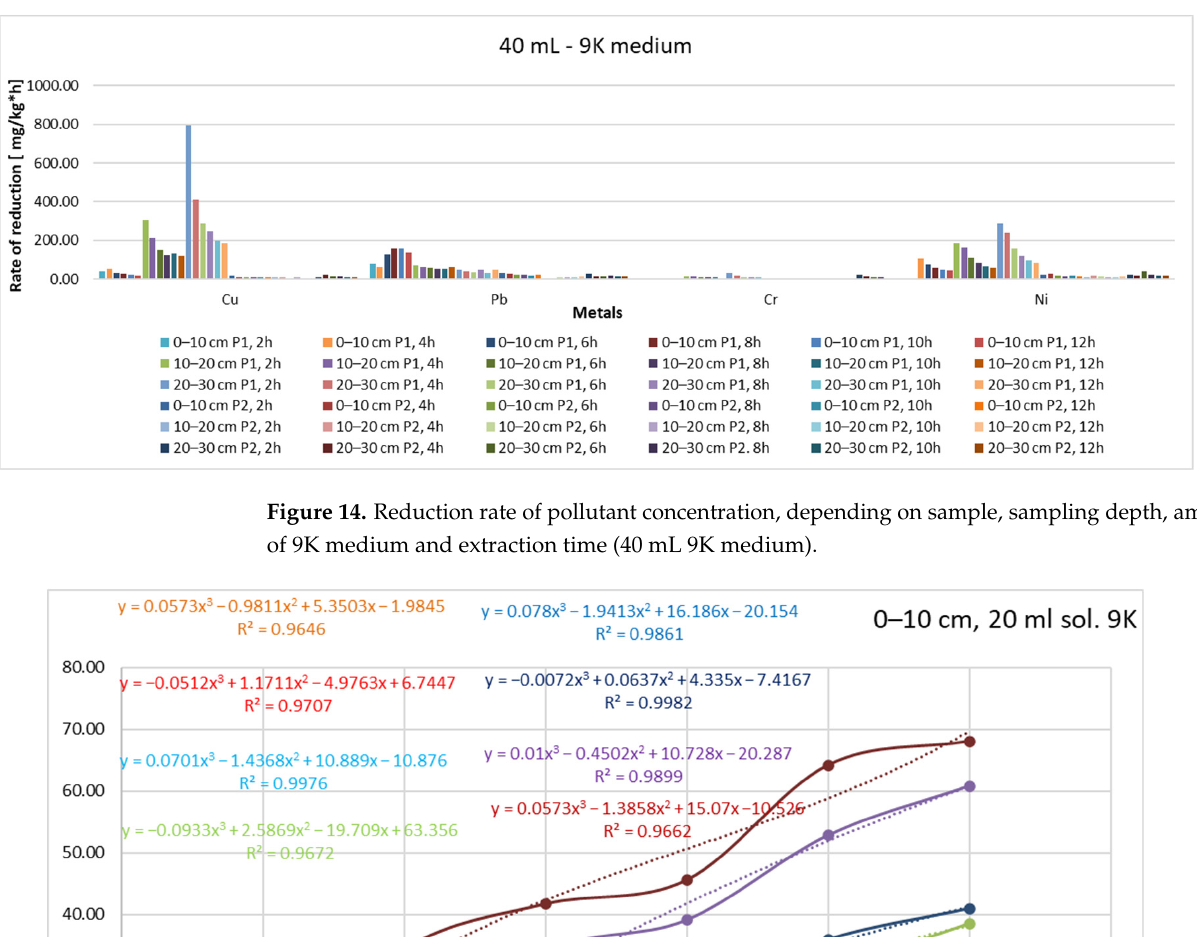
Figure 14. Reduction rate of pollutant concentration, depending on sample, sampling depth, amount of 9K medium and extraction time (40 mL 9K medium).